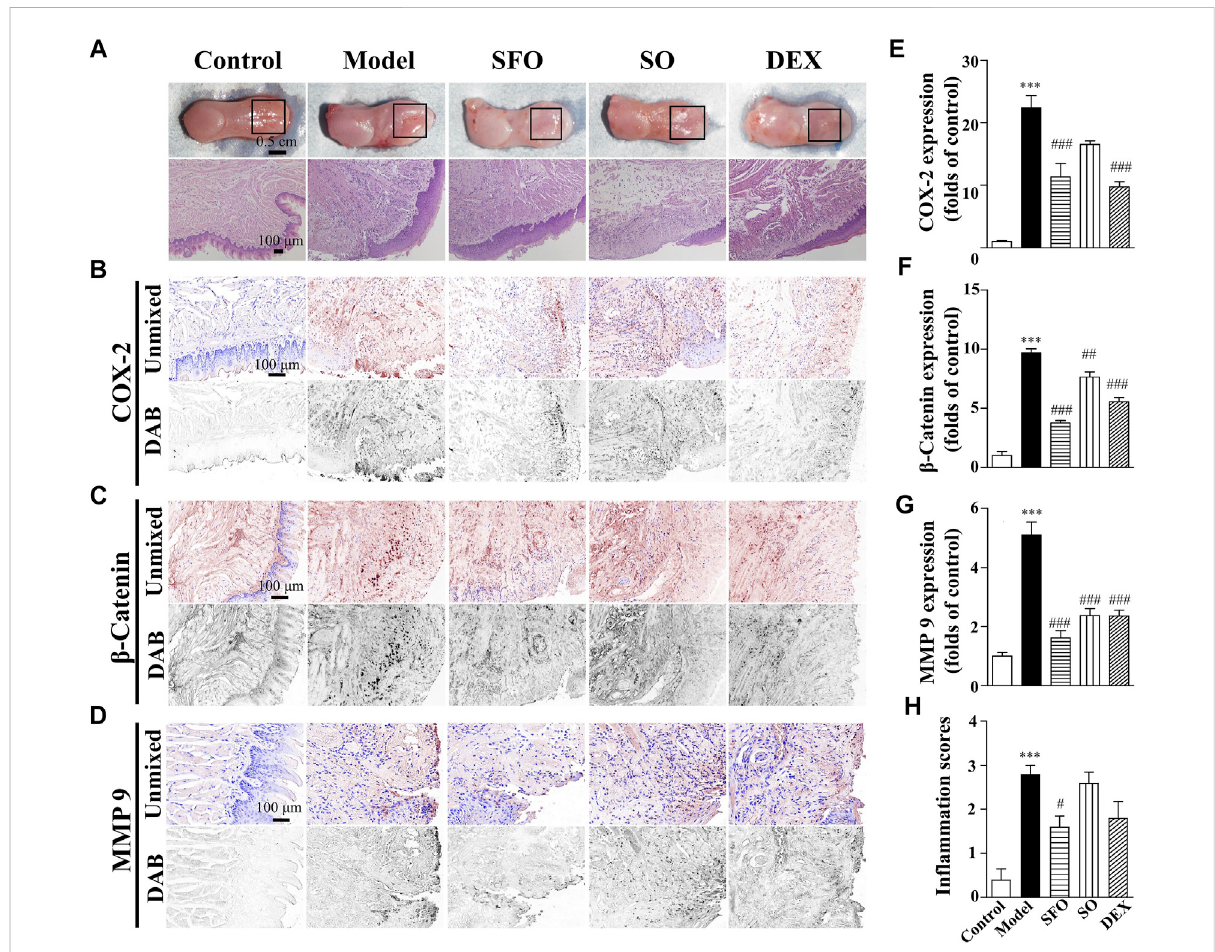
FIGURE 1 Wound healing acceleration by ShengFu oil in tongue of boiling water-burned mice. (A) General view of the tongue samples, and H&E staining of tongue sections in control, model, ShengFu oil (SFO), dexamethasone (DEX), and sesame oil (SO) groups. Representative (B – D) and summary (E – G) of histochemistry analysis of expression of COX-2, β -catenin and MMP-9, respectively. (H) The in fl ammation scores of the tongue samples in theH&E-stainedimages.Scalebar,100 µm.Comparedwiththecontrolgroup, ppp , p < 0.001.Comparedwiththemodelgroup,#, p < 0.05,##, p < 0.01, ###, p <